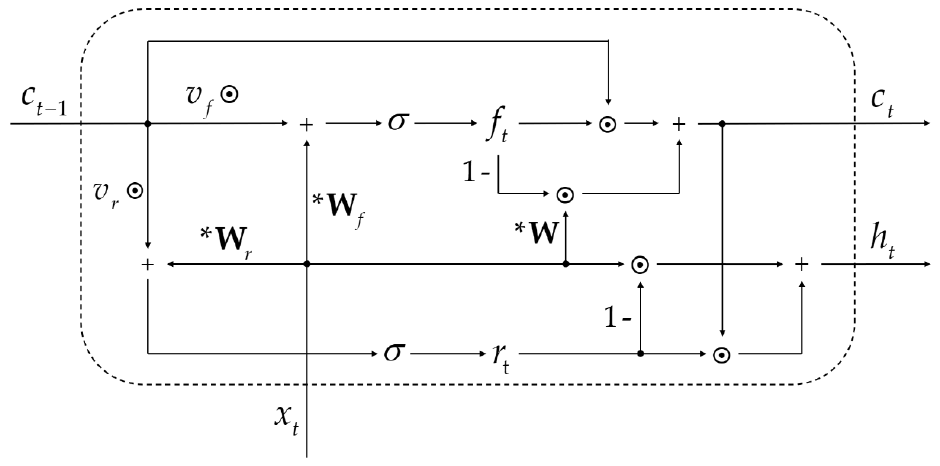
Figure 3. The architecture of SRU. x t is the input vector, C t is the internal state, c t − 1 is the pre- vious state, f t is the forget gate, r t is the reset gate, and h t is the output state. * represents matrix